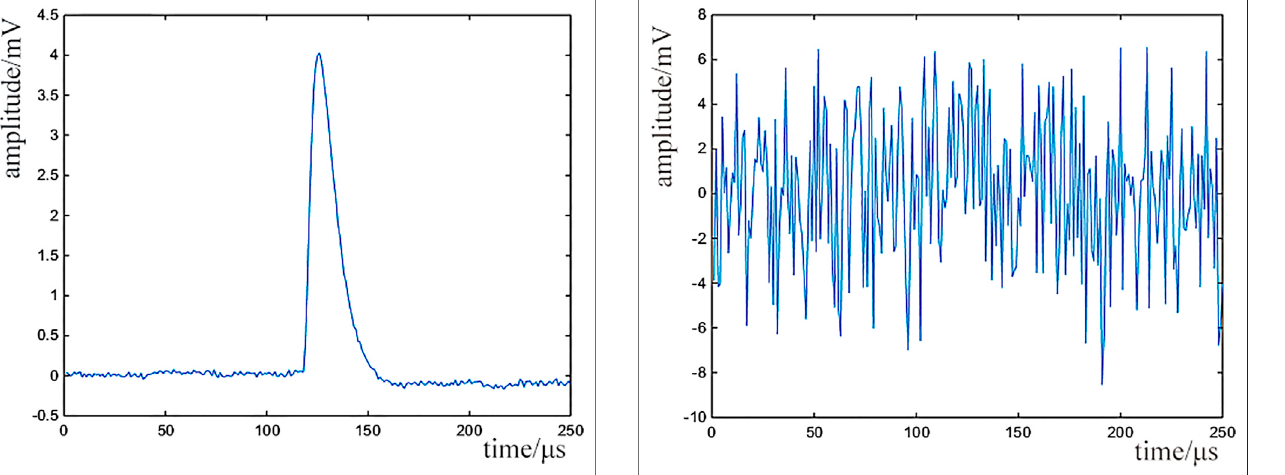
FIGURE 4 | Measured nuclear pulse signals in the laboratory. FIGURE 5 | Measured nuclear pulse signals with noise superimposed in